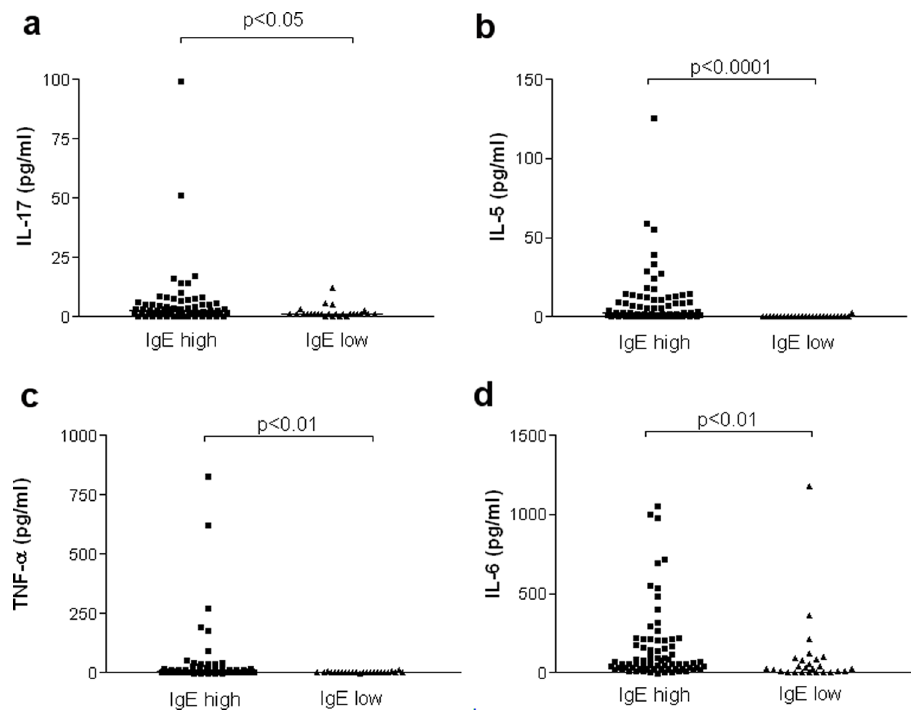
Figure 4. Cytokine levels in ‘‘IgE high’’ and ‘‘IgE low’’ asthmatics. doi:10.1371/journal.pone.0058388.g004 PLOS ONE |